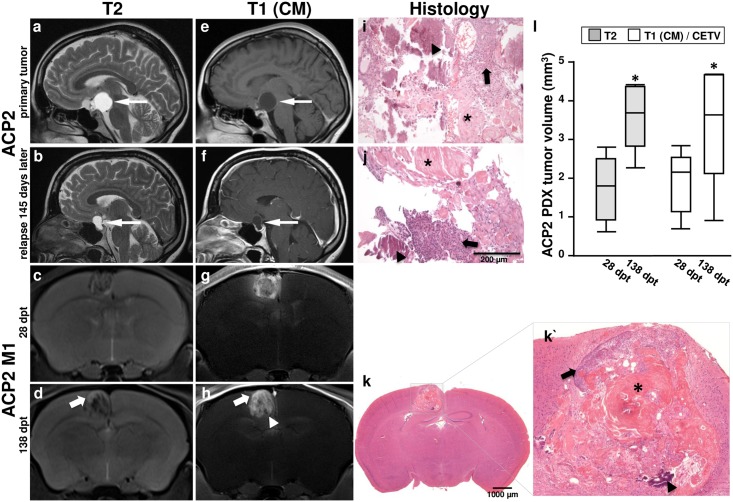
Comparison of primary human MRI and histology with the induced model.MR images and corresponding histology of an ACP patient (ACP2) showing the primary tumor and relapse after 145 days are illustrated in comparison with an example of a direct vital descendent of the surgically removed primary tumor specimen implanted into the nude mouse number one out of ten (ACP2 M1). T2 weighted images show a cystic component within the craniopharyngioma in the human patient (a and b; arrow) with contrast enhancement in the rim of the lesion (e and f; arrow) at baseline (a and e) as compared to 145 days later (b and f) with an increase in size over time. The craniopharyngioma xenograft in the mouse is inhomogeneous in T2 (c and d) and post contrast T1 (g and h) weighted images. The T2w hyperintense and T1 contrast enhancing areas in the tumor increase over 110 days as well (c and d; g and h). Histology of the primary tumor (i) shows similar characteristics to the descendent tumors in human (j) and in mice (k and k`) in terms of vital tumor proportions (arrow), wet keratin (asterisk) and calcification (arrowhead). Vital tumor areas (arrow, k´) in the murine graft were also identified on MRI (arrows, d and h) by T2 hyperintensity and contrast enhancing areas in T1. However, calcified regions appear hypointense (arrowhead, k´, d and h). PDX tumor volume (n = 5) defined 28 and 138 days post transplantation (dpt) in T2 weighted as well as post contrast T1 weighted images revealed a significant increase over time (p<0.05) (l).